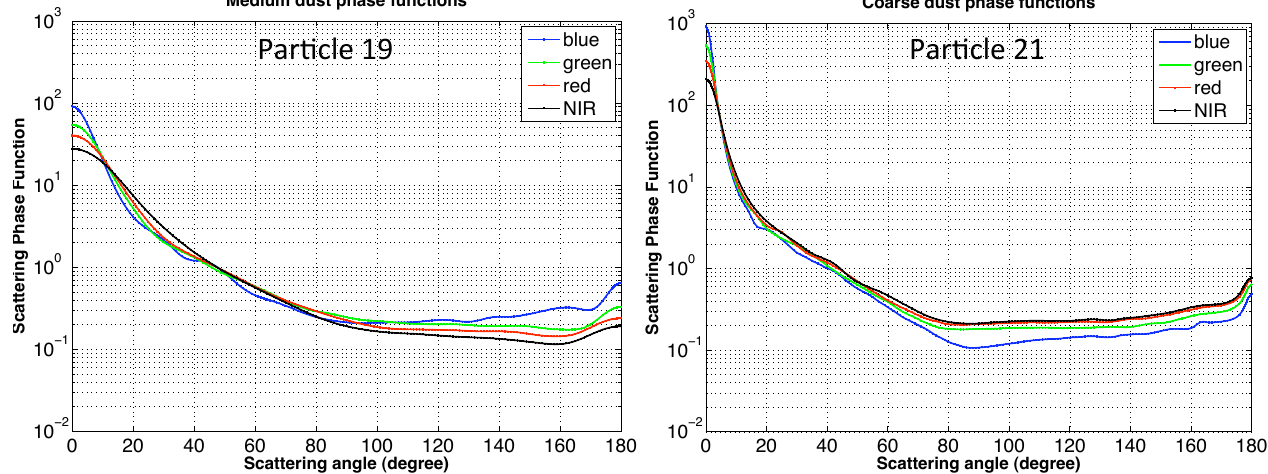
Fig. 1. The scattering phase functions of MISR Particle 19 (medium dust) and MISR Particle 21 (coarse dust) at the four MISR wavelengths: 447nm (blue), 558nm (green), 672nm (red), and 866nm (NIR). Optical properties of these models are listed in Table